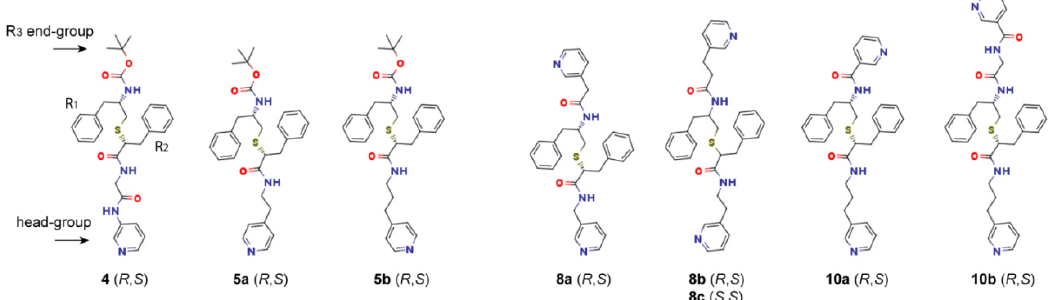
Figure 2. Chemical structures of series VI analogues. The pyridine head-group, R 1 /R 2 -phenyl side groups and their stereo configuration, and terminal R 3 moiety are indicated.